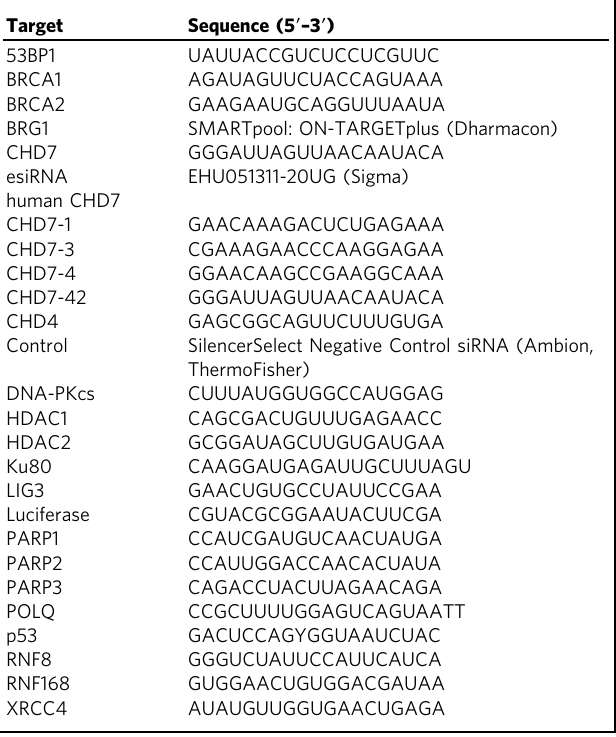
Table 1 List of siRNAs.